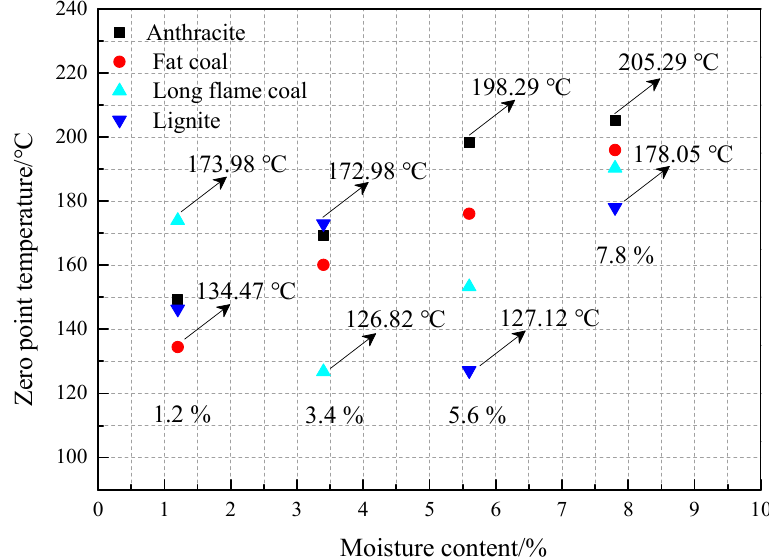
Figure 11. Comparison of the zero point of heat flow difference for anthracite, fat coal, long flame coal and lignite at the same low moisture content. and lignite at the same low moisture